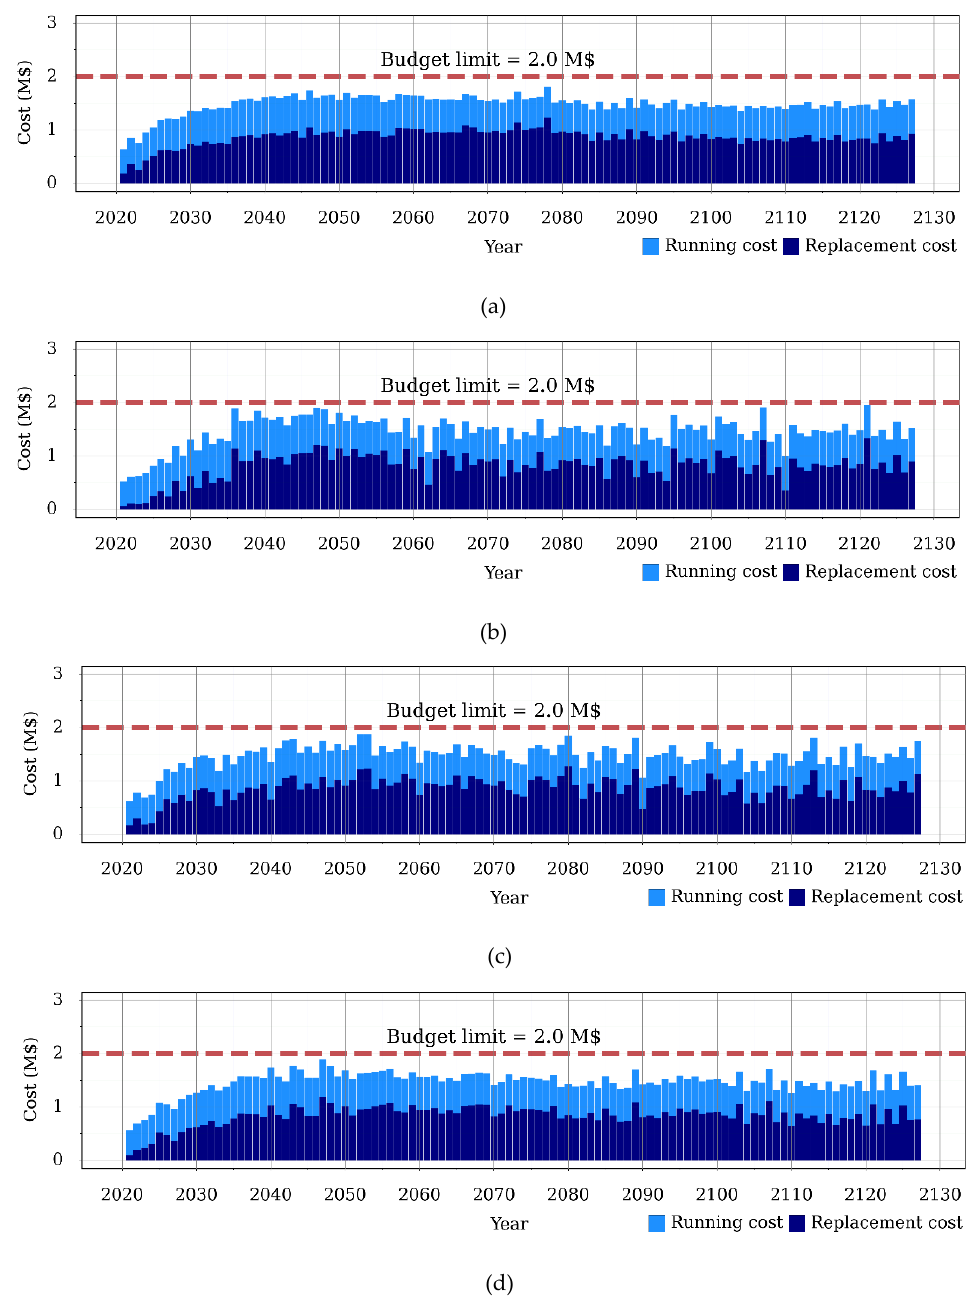
Figure 12. Future investment time series for Scenario 3: ( a ) Solution 1—min. SD of annual investment, ( b ) Solution 2—min. imposed LCC, ( c ) Solution 3—min. system age, and ( d ) Solution 4—knee-point.